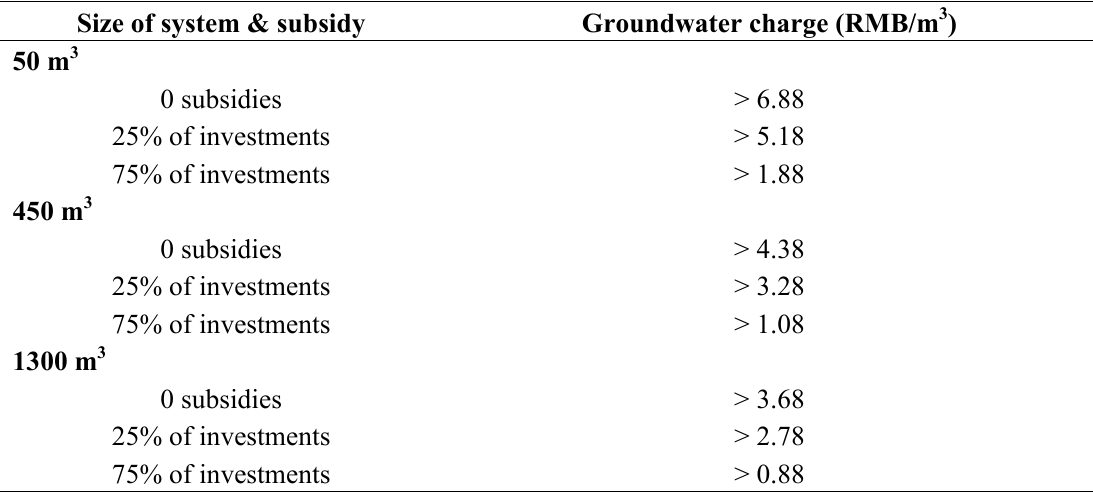
Table 5. Groundwater charge corresponding to different sizes and subsidies for RWH